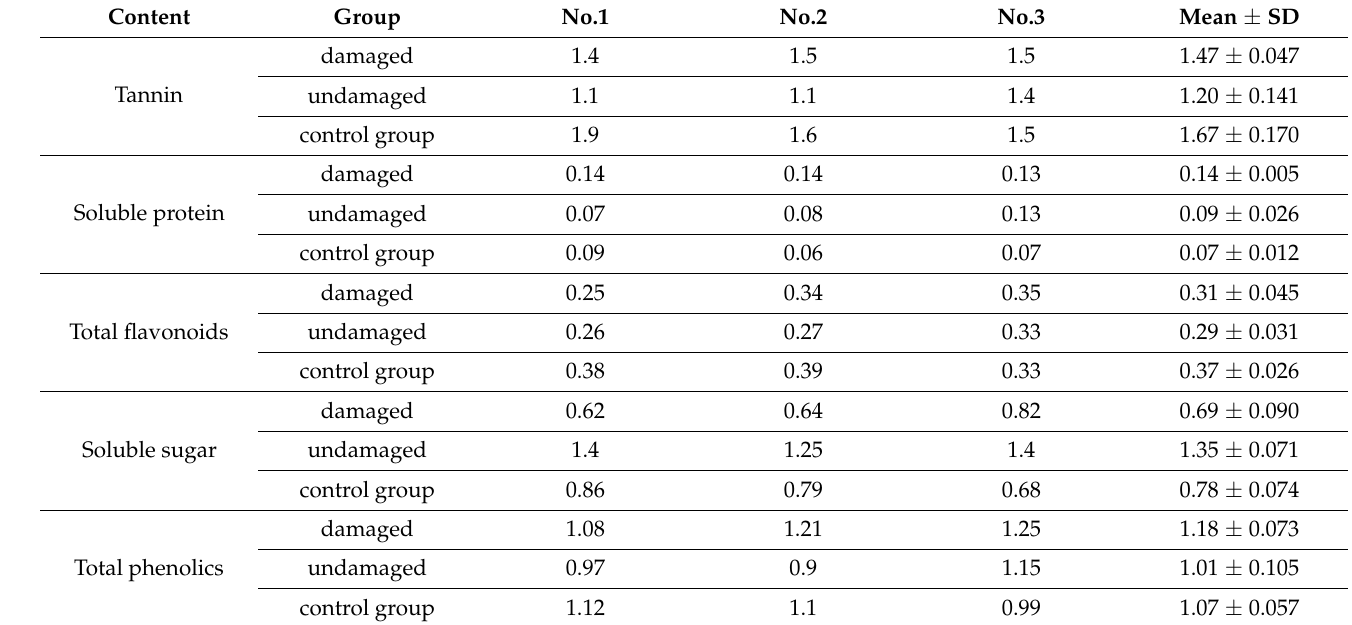
Table 1. Measuring data of secondary biomass and nutrient content in host plant leaves affected by C. ciliata . Figure 1. Contents of secondary biomass and nutrients in host plant leaves affected by C. ciliata .